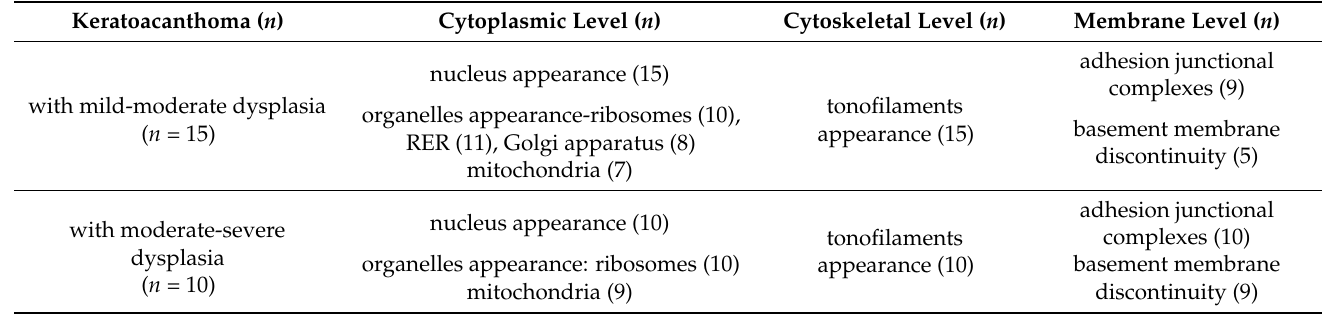
Figure 3. TEM. Keratoacanthoma with moderate-severe dysplasia: ( a ) the enlargement of the perinu- clear cisterna; ( b ) powerfully edentate nucleuses; ( c ) highly thickened tonofilaments retreating from the desmosomes; and ( d ) presence of desmosomes and HD with disorganized structure. Table 1. Ultrastructural